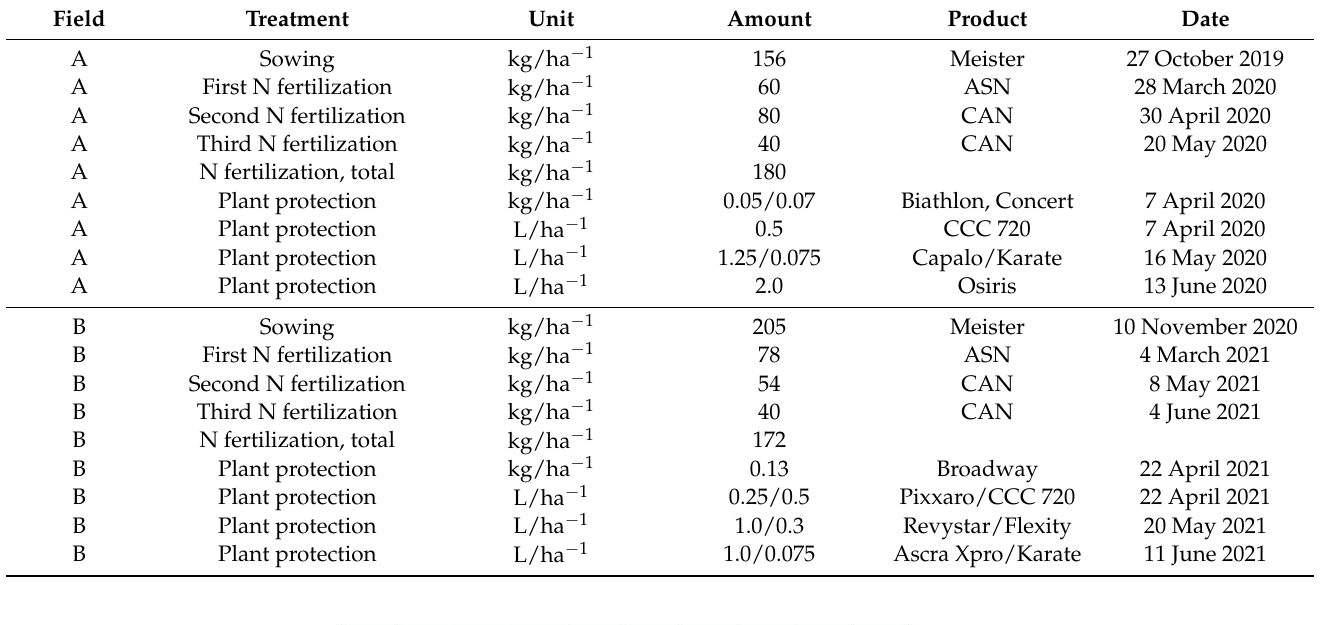
Table 3. Crop management of the trial fields.